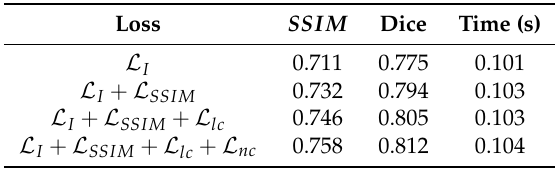
Table 4. Ablation study on varying loss combination.